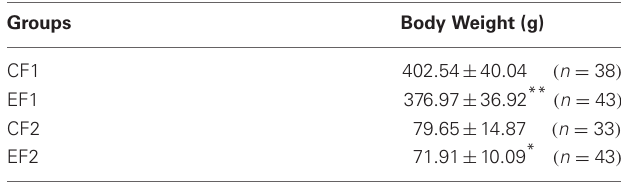
Table 3 | Body weights of F1 and F2